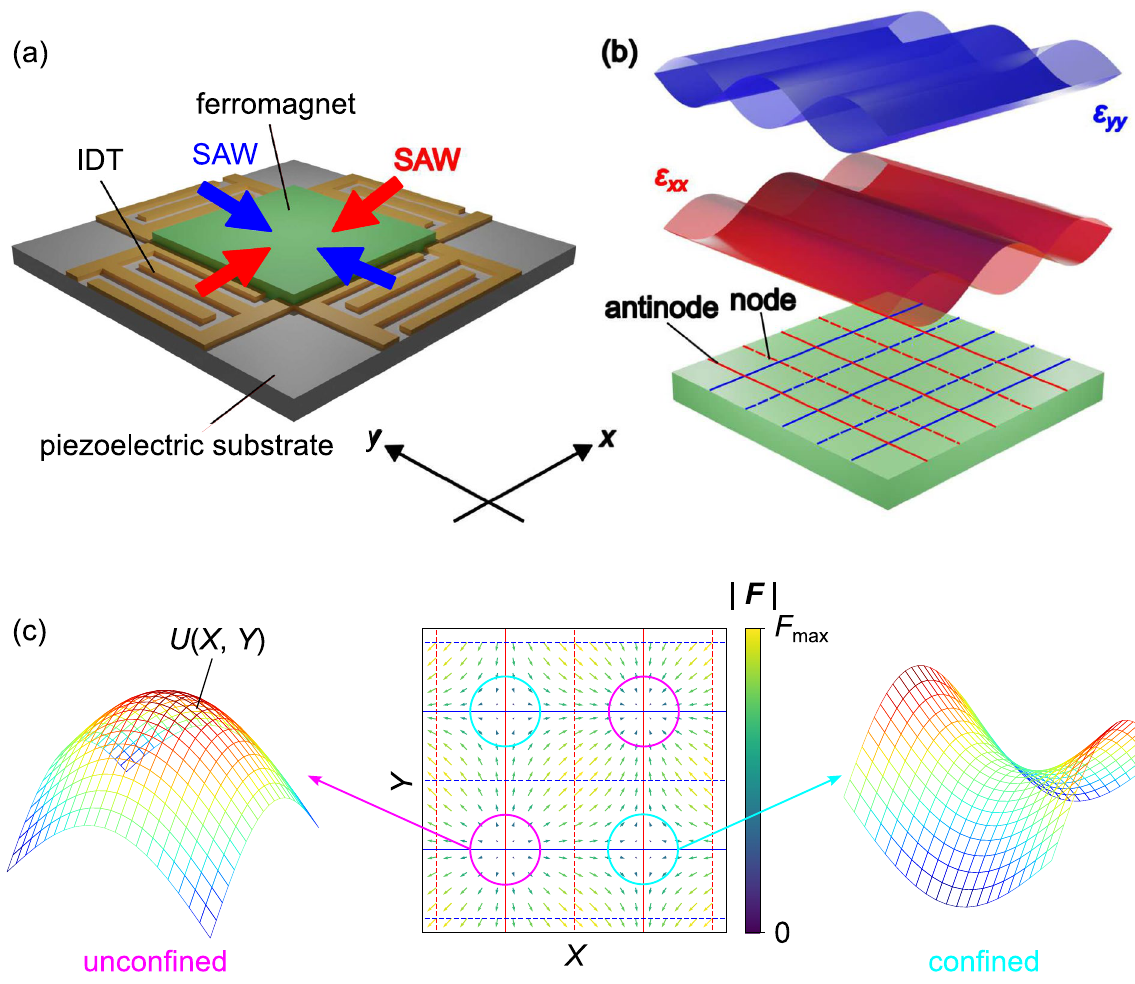
Figure 2. Device structure and potential at antinodes. ( a ) Schematic illustration of the device structure. A ferromagnetic film which hosts skyrmions is deposited on a piezoelectric substrate. Counter-propagating SAWs in x and y directions are generated by four IDTs. ( b ) Wave forms of strains ǫ xx and ǫ yy in ferromagnetic thin film. Dashed and solid lines indicate the positions of nodes and antinodes of SAWs (red: ǫ xx , blue: ǫ yy ), respectively. ( c ) The force field F ( R ) due to the gradient of strains, which acts on the skyrmion (center). The left U at the intersections of antinodes. Two and right figures show the shape of potential U ( R ) defined as F = −∇ types of potentials are observed: convex-shaped (left) and saddle-shaped (right) potentials. Note that due to the temporal oscillation of SAWs, the signs of the potentials are reversed periodically with time. The saddle-shaped potential shown in the right figure has a similar form to a quadrupole ion trap and produces a confining force for